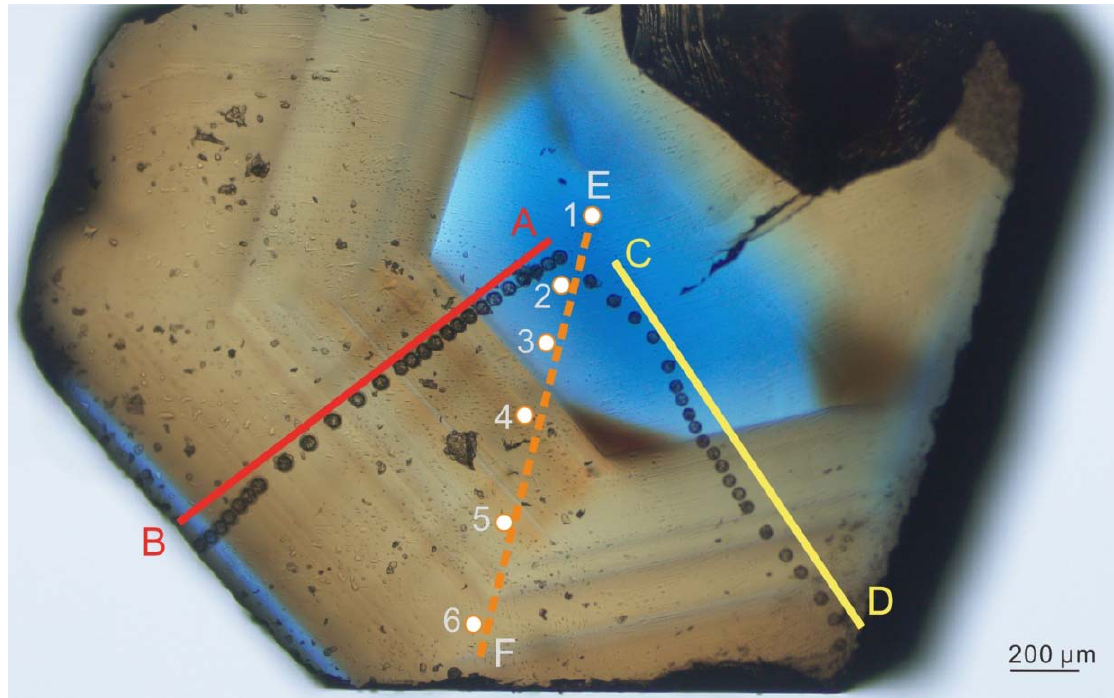
Figure 4. Photomicrographs of cross-section along the vertical c-axis of sample Sap-1, showing plots performed by LA–ICP–MS from core to rim over two profiles (AB, CD), and six FTIR-analyzed plots over profile EF.